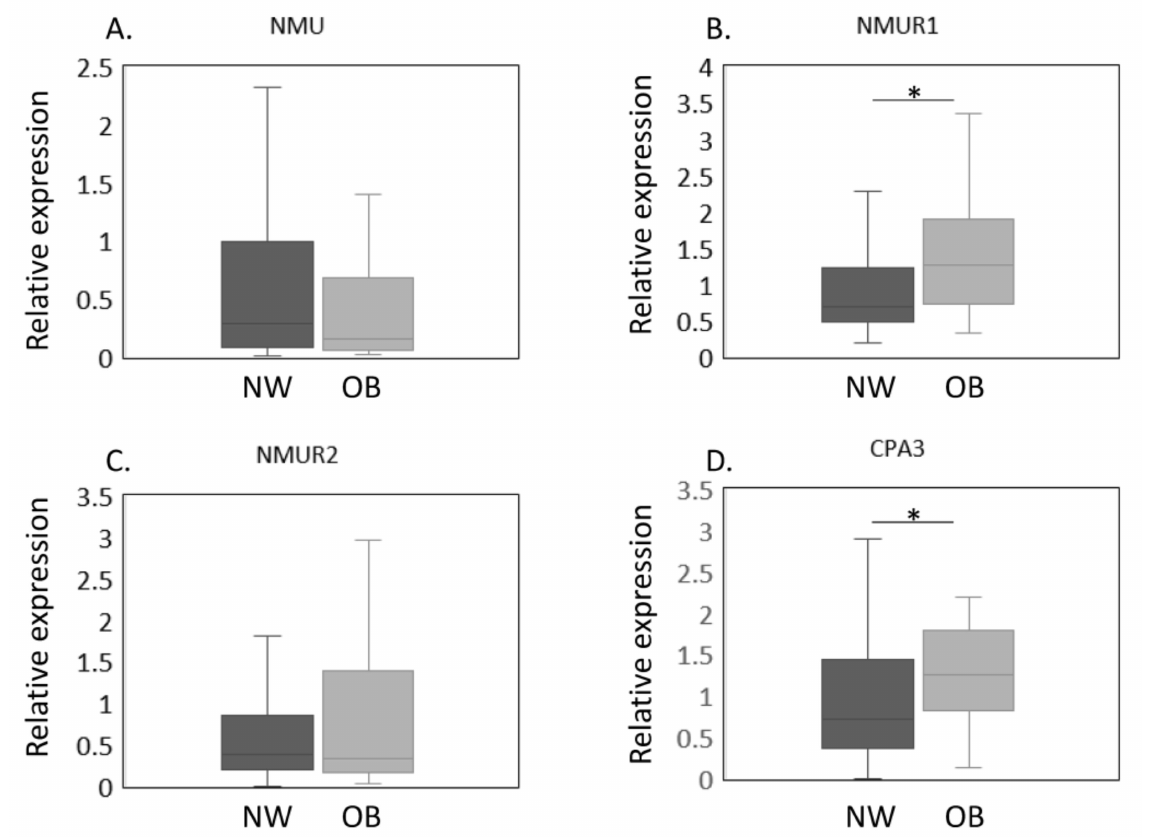
Figure 2. Expression of NMU / NMURs and CPA3 in normal-weight and obese groups after propensity score matching. The expression of NMU / NMURs and CPA3 mRNA in normal-weight (NW, n = 38) and obese (OB, n = 38) groups in a propensity score-matched cohort was estimated by qPCR ( A – D ). The expression of NMU ( A ), NMUR1 ( B ), NMUR2 ( C ), CPA3 ( D ) mRNA in the synovial membrane of NW and OB patients with knee osteoarthritis after propensity score matching. Gene expressions are presented in box and whisker plots, showing the median, 25th, and 75th percentiles and range. * p <